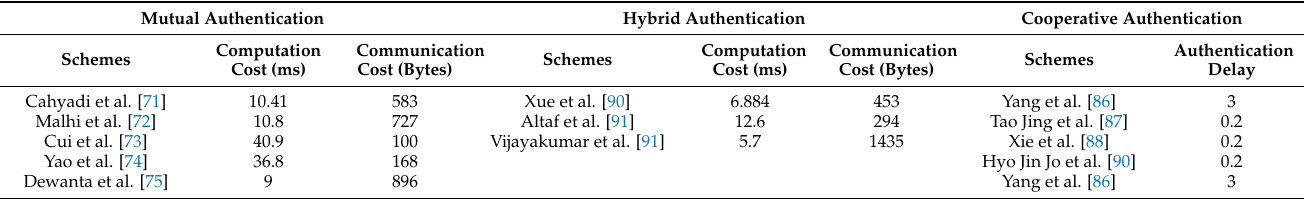
Table 17. Performance comparison of mutual, cooperative, and hybrid authentication schemes based on computation and communication costs.